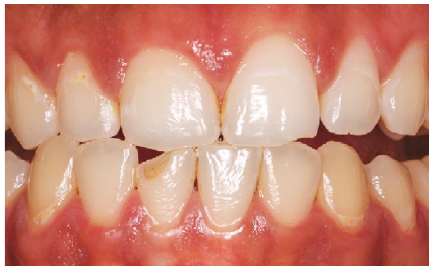
Figure 1: Fingertip mutilation associated with generalized parony- chia and onycholysis.